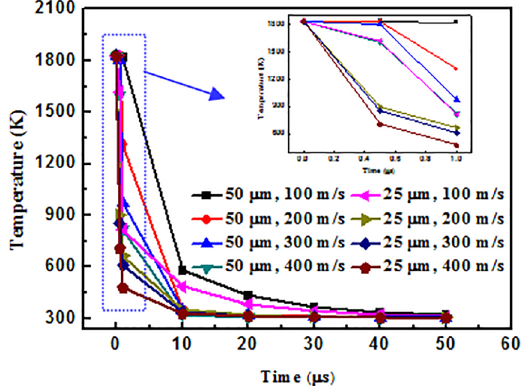
Figure 12. Relationships between droplet solidification temperature and impact time The surface morphology of Ni-Al powder for 0.3 MPa